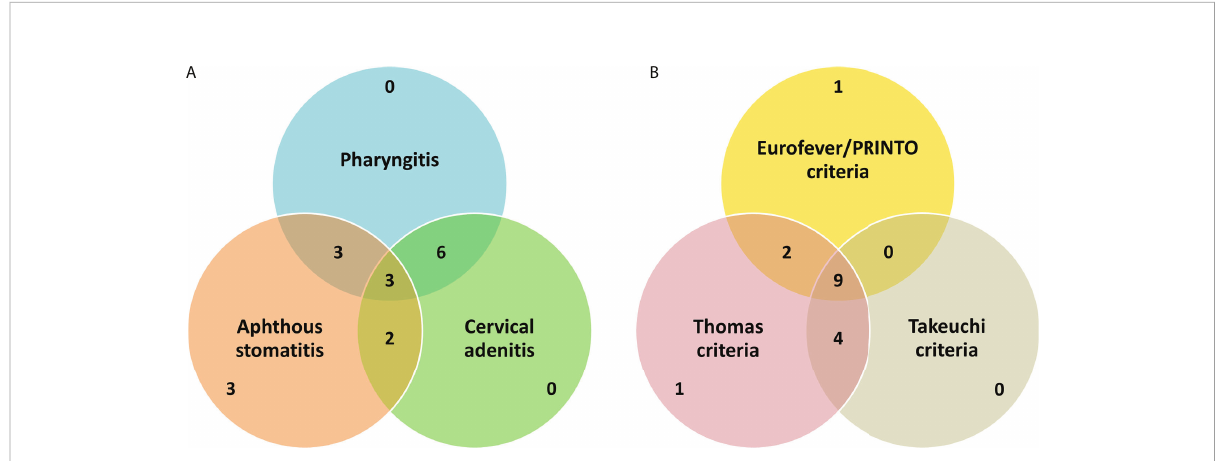
FIGURE 1 A brief summary of the basic clinical features (A) and performance of the various criteria for PFAPA (B) in our cohort. Values in the Venn diagrams refer to the absolute number of patients ful fi lling particular diagnostic/classi fi cation criteria or having classical clinical